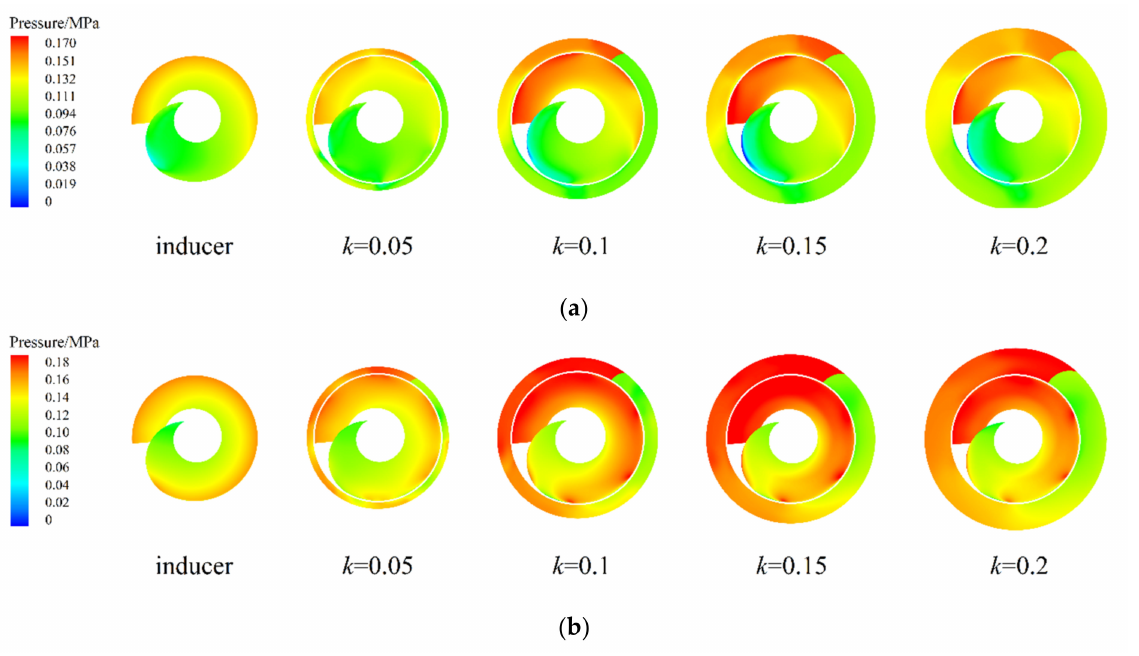
Figure 9. Static pressure distribution under different radial height. Static pressure distribution on suction surface ( a ). Static pressure distribution on pressure surface ( b ).